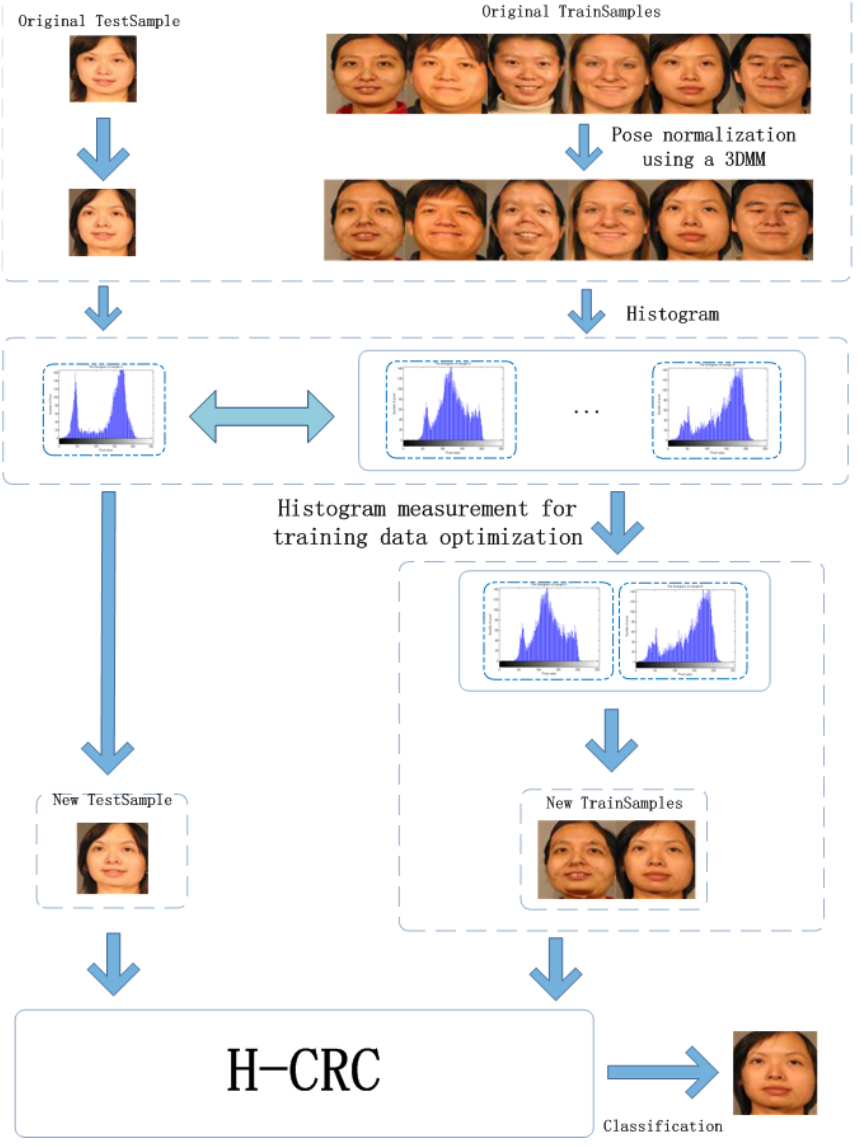
Figure 1. The schematic diagram of the proposed